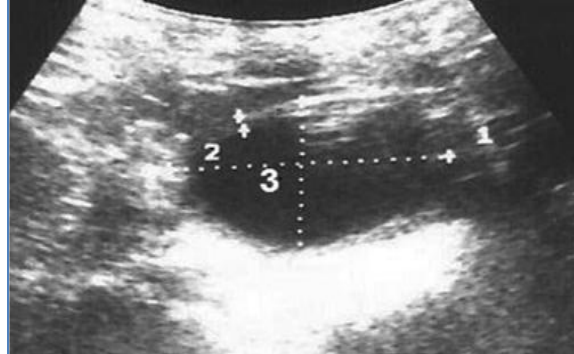
Figure, 8: Percutaneous ultrasonograms of normal urinary bladder of calve from right paralumbar area, 3.5MHz. 1= horizontal diameter, 2=wall thickness, 3=vertical diameter.